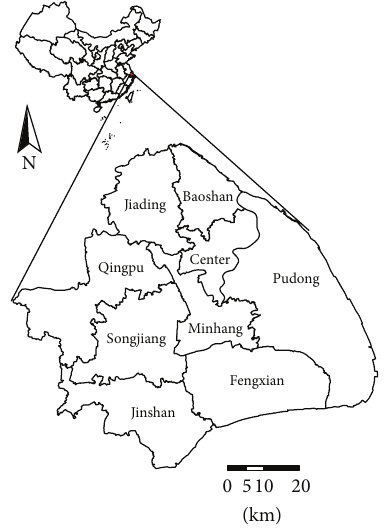
Figure 1: Location of the study